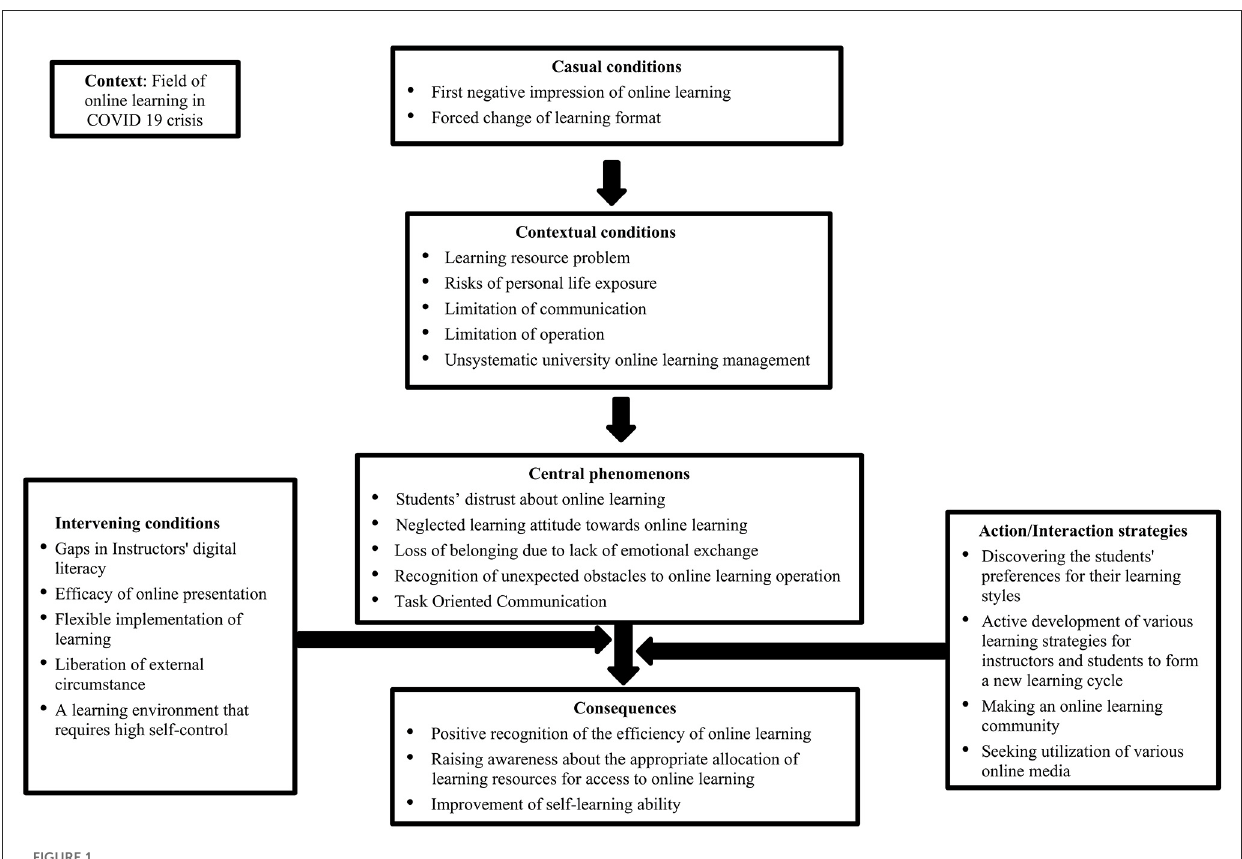
FIGURE1 Paradigm model of the online learning